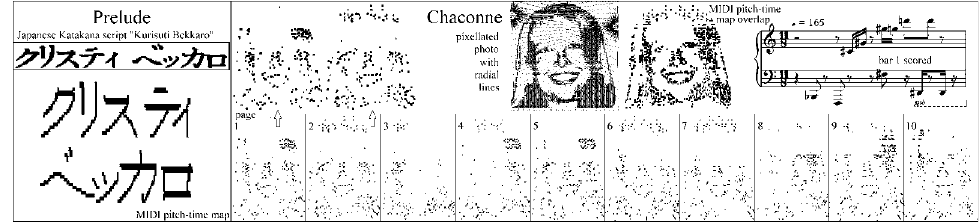
lines three degrees apart, 20 of them unused – see comment below, 2) a harmonic matching of my piece ... until ... #5 (1972/74) in 11/16 metre, frequently played by Ms Becker (each of the ten mappings scans eight bars or 88 pulses of this piece, reflected in the eight bars of each page of Kuri Suti Bekar ), and 3) a phonetic spectral analysis, serving as a sonic filter, of three Bengali words also forming the title: “kuri” (twenty), “suti” (cotton threads) and “bekar” (jobless), referring to the 20 idle radial lines. Superimposed, the ten pitch maps yield the graph at top centre right, clearly resembling the pixellated photograph. Bar one of the score is at top right. See also references (Barlow, 2009a, 2010a, 2012,